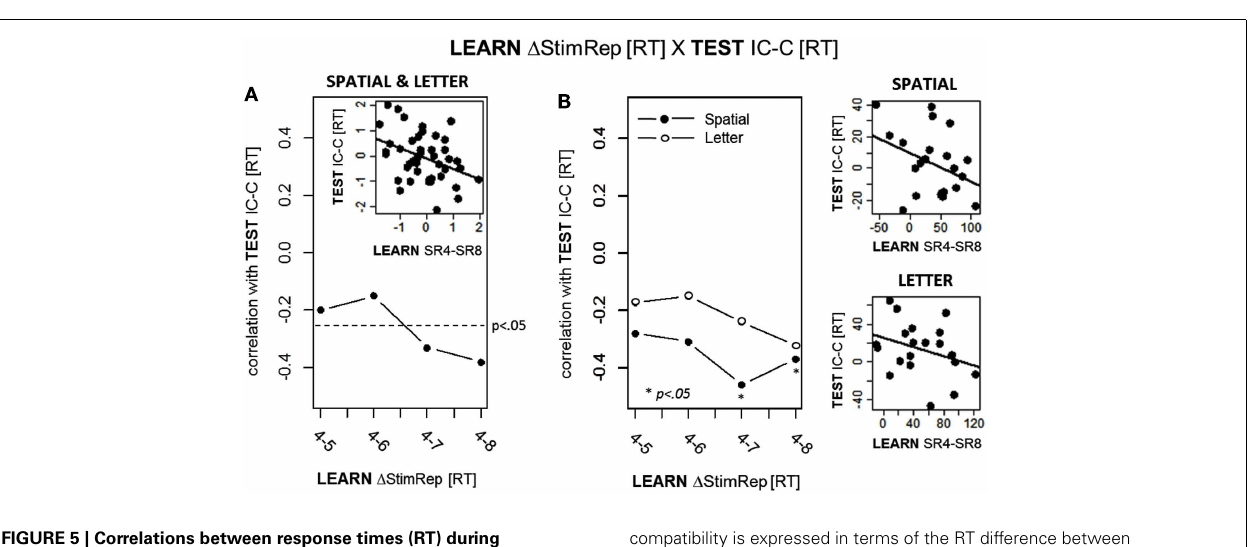
FIGURE 5 | Correlations between response times (RT) during ongoing learning and RTs during the subsequent response-effect (R-E) compatibility test in Exp. 2A and 2B. Ongoing learning is expressed in terms of the RT difference between Stimulus Repetition (StimRep) 4 and the subsequent StimRep levels (i.e., ∆ StimRep). R-E